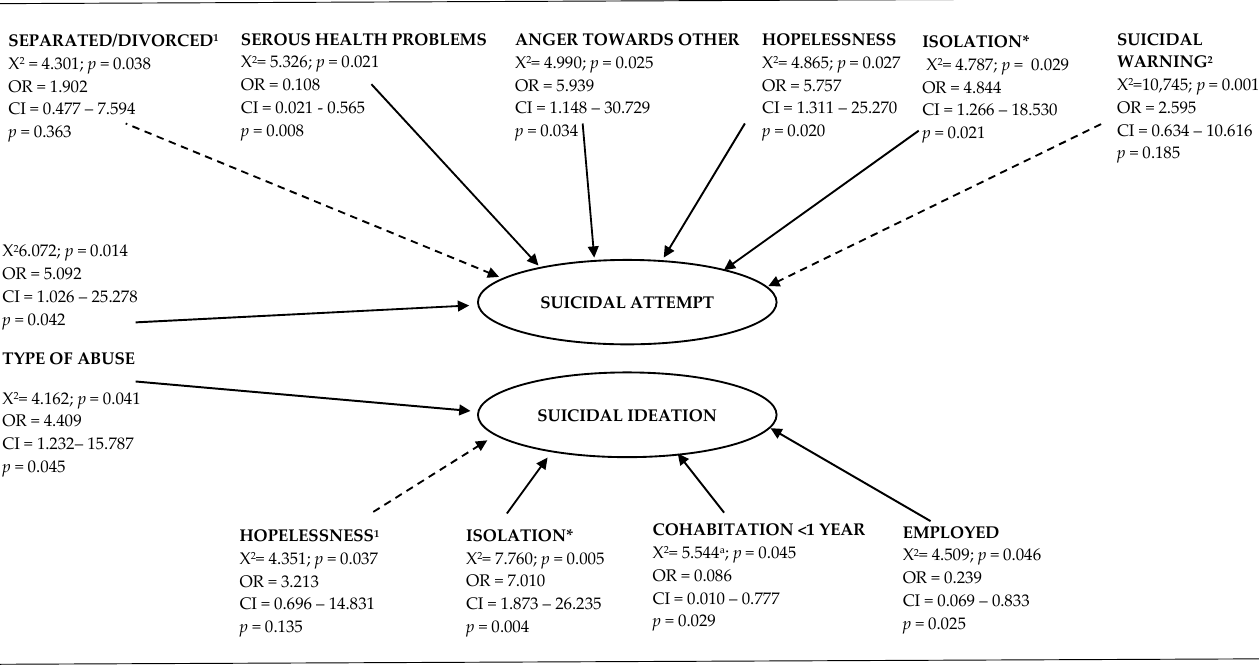
Figure 1. Logistic regression analysis of suicide attempts and suicidal ideation in a group of victimized women. (a) Fisher’s exact